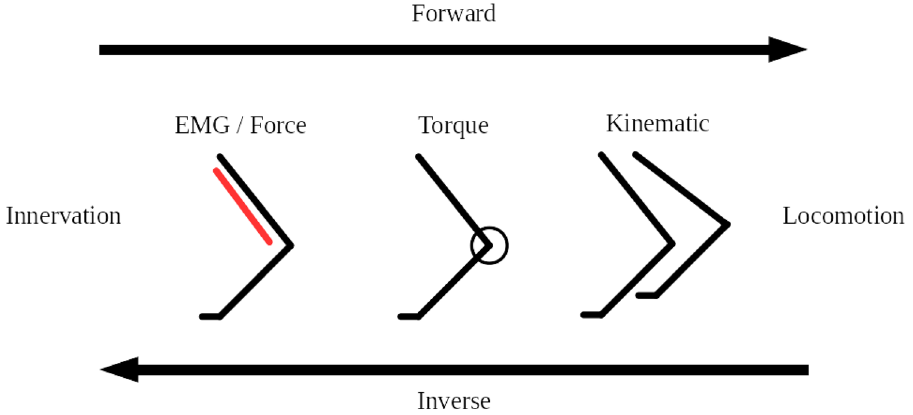
Figure 1. Abstraction of the forward and inverse simulation parameter chain for forelimb locomotion. Depending on the direction of the examination, the chain starts on the left or right side. The figure was created with the software package LibreOffice 71